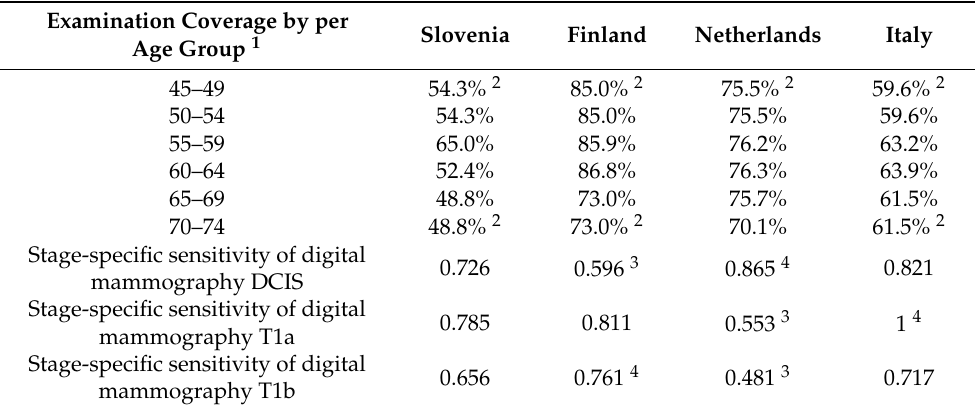
Table 1. Input values for the parametric sensitivity analysis, per